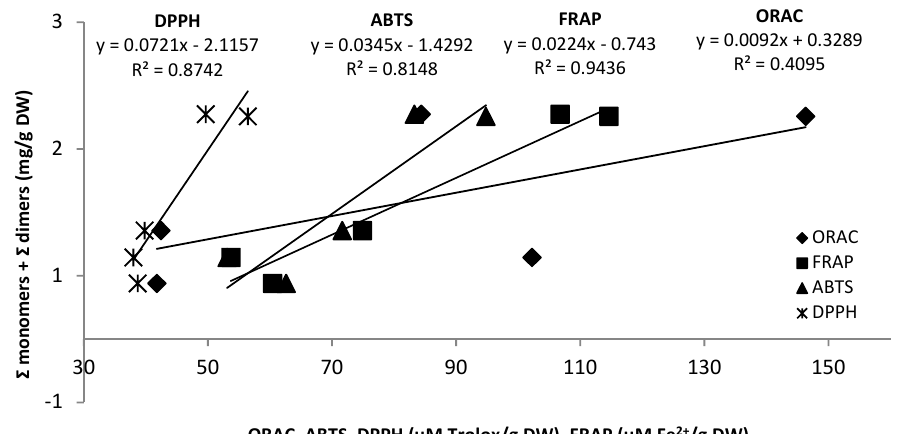
Figure 2. Correlations between radical scavenging capacity assays (ORAC, FRAP, ABTS and DDPH) and total proanthocyanidin content (sum of monomers and dimers) in grape pomace seeds in